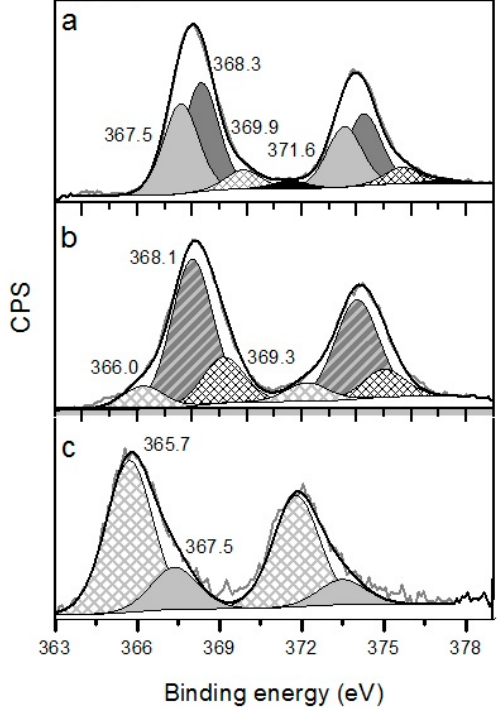
Figure 6. XPS of lines Ag 3d5/2 for Ag catalysts supported on Mg/TiO 2 ( a ), Fe/TiO 2 ( b ) and Ce/TiO 2 ( c ) after reduction in H2 at 300 °C for 1 h.